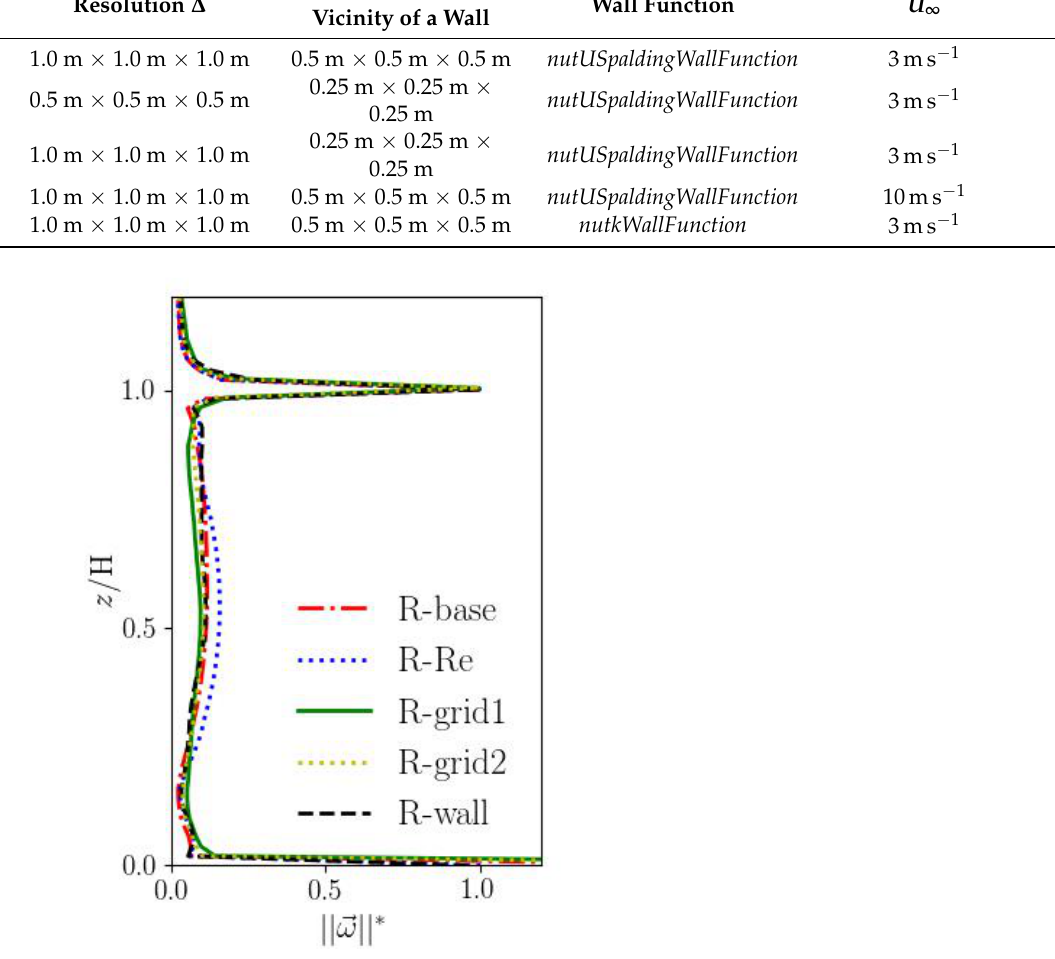
Figure A2. Vertical profiles of the normalised vorticity magnitude for the numerical configurations of Table A3 and an external wind at